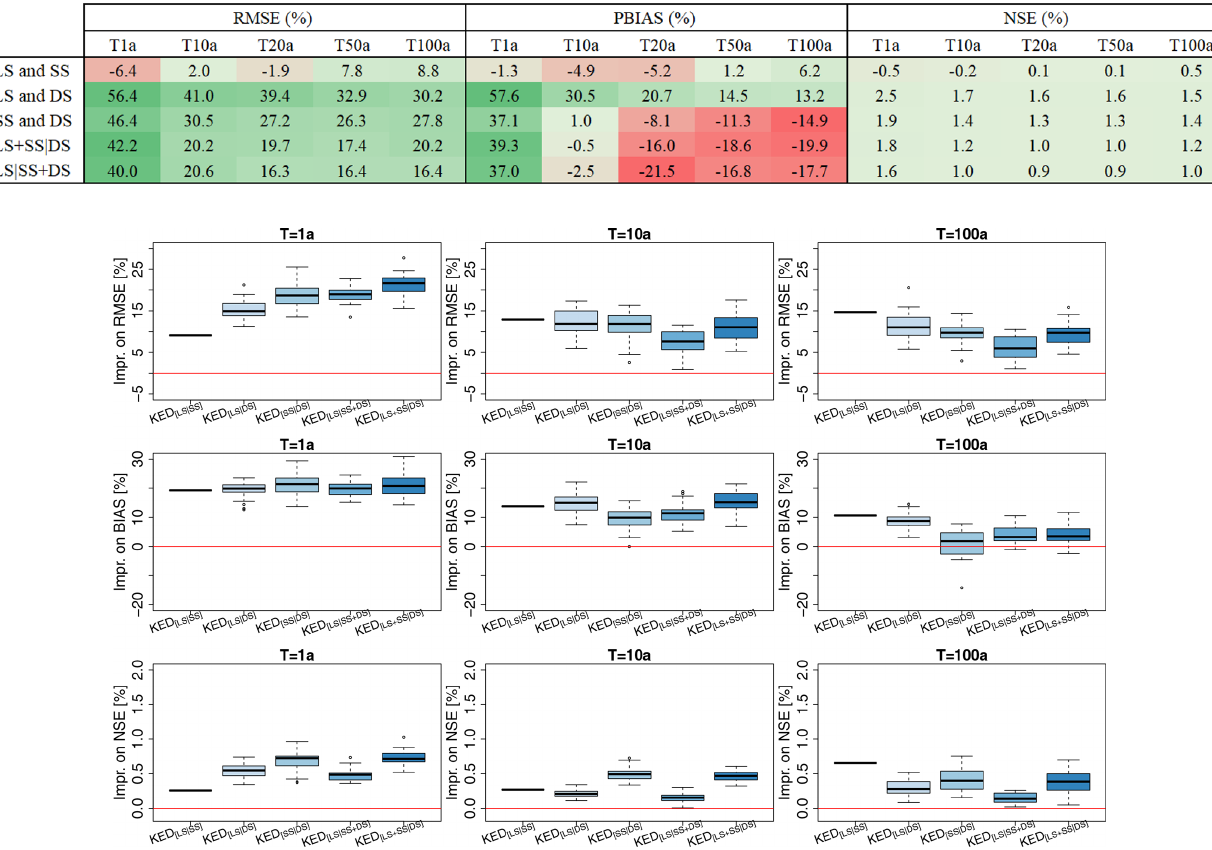
Figure 12. Median performance improvements towards the benchmark from regionalising on different data combinations, as per Table 7, in kriging with external drift, where SS is the short series, LS is the long series and DS is the disaggregated daily series, combined either with the same importance ( + ) or with priority importance ( | ).